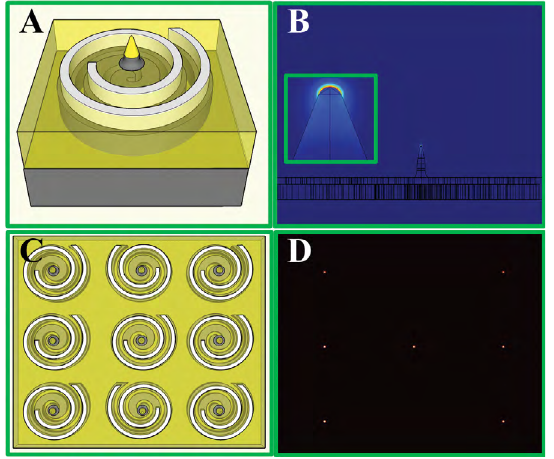
Figure 18 (A) Diagram of the proposed near-field plasmonic probe consisted of two spiral plasmonic antennas and a composite conical tip at the center. (B) Simulated intensity distribution on the probe with LHS plasmonic antenna under RHC polarized illumination. (C) Schematic drawing of an array of the near-field probe. The array consists of spirals with alternative handedness. (D) Simulated intensity distribution at 10 nm above the tip apex for RHC polarized illumination. Adapted from Ref.